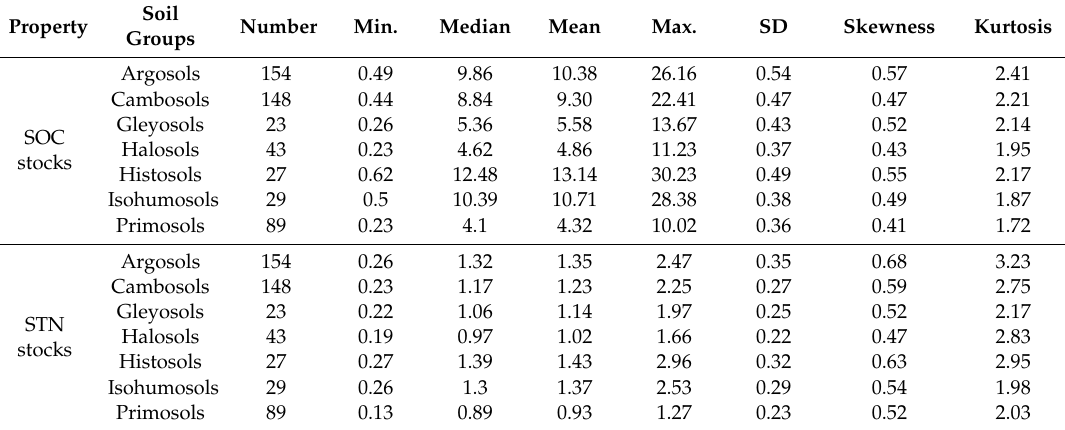
Table 2. Summary statistics of topsoil (0–30 cm) soil organic carbon (SOC) stocks (kg m − 2 ) and soil total nitrogen (STN) stocks (kg m − 2 ) of each soil group according to the Chinese soil system classification at sampling